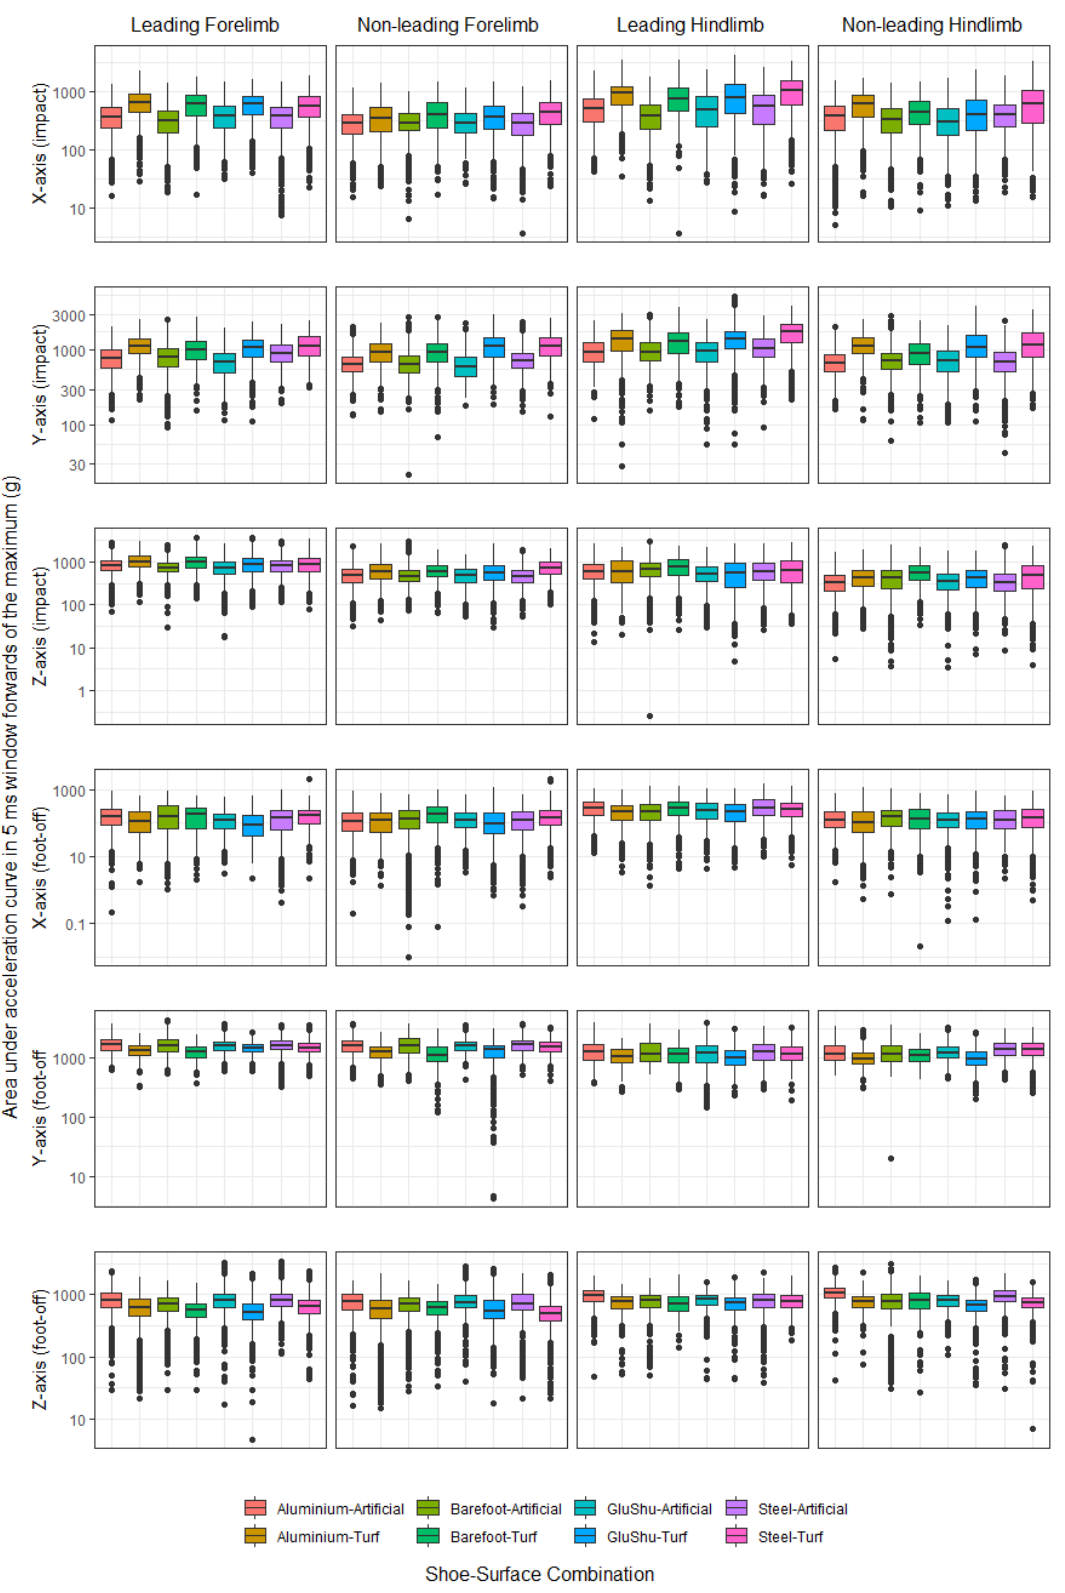
Figure A5. Boxplots illustrating the summed (positive) acceleration data in the 5 ms window ahead of the maximum, subdivided according to shoe – surface condition.